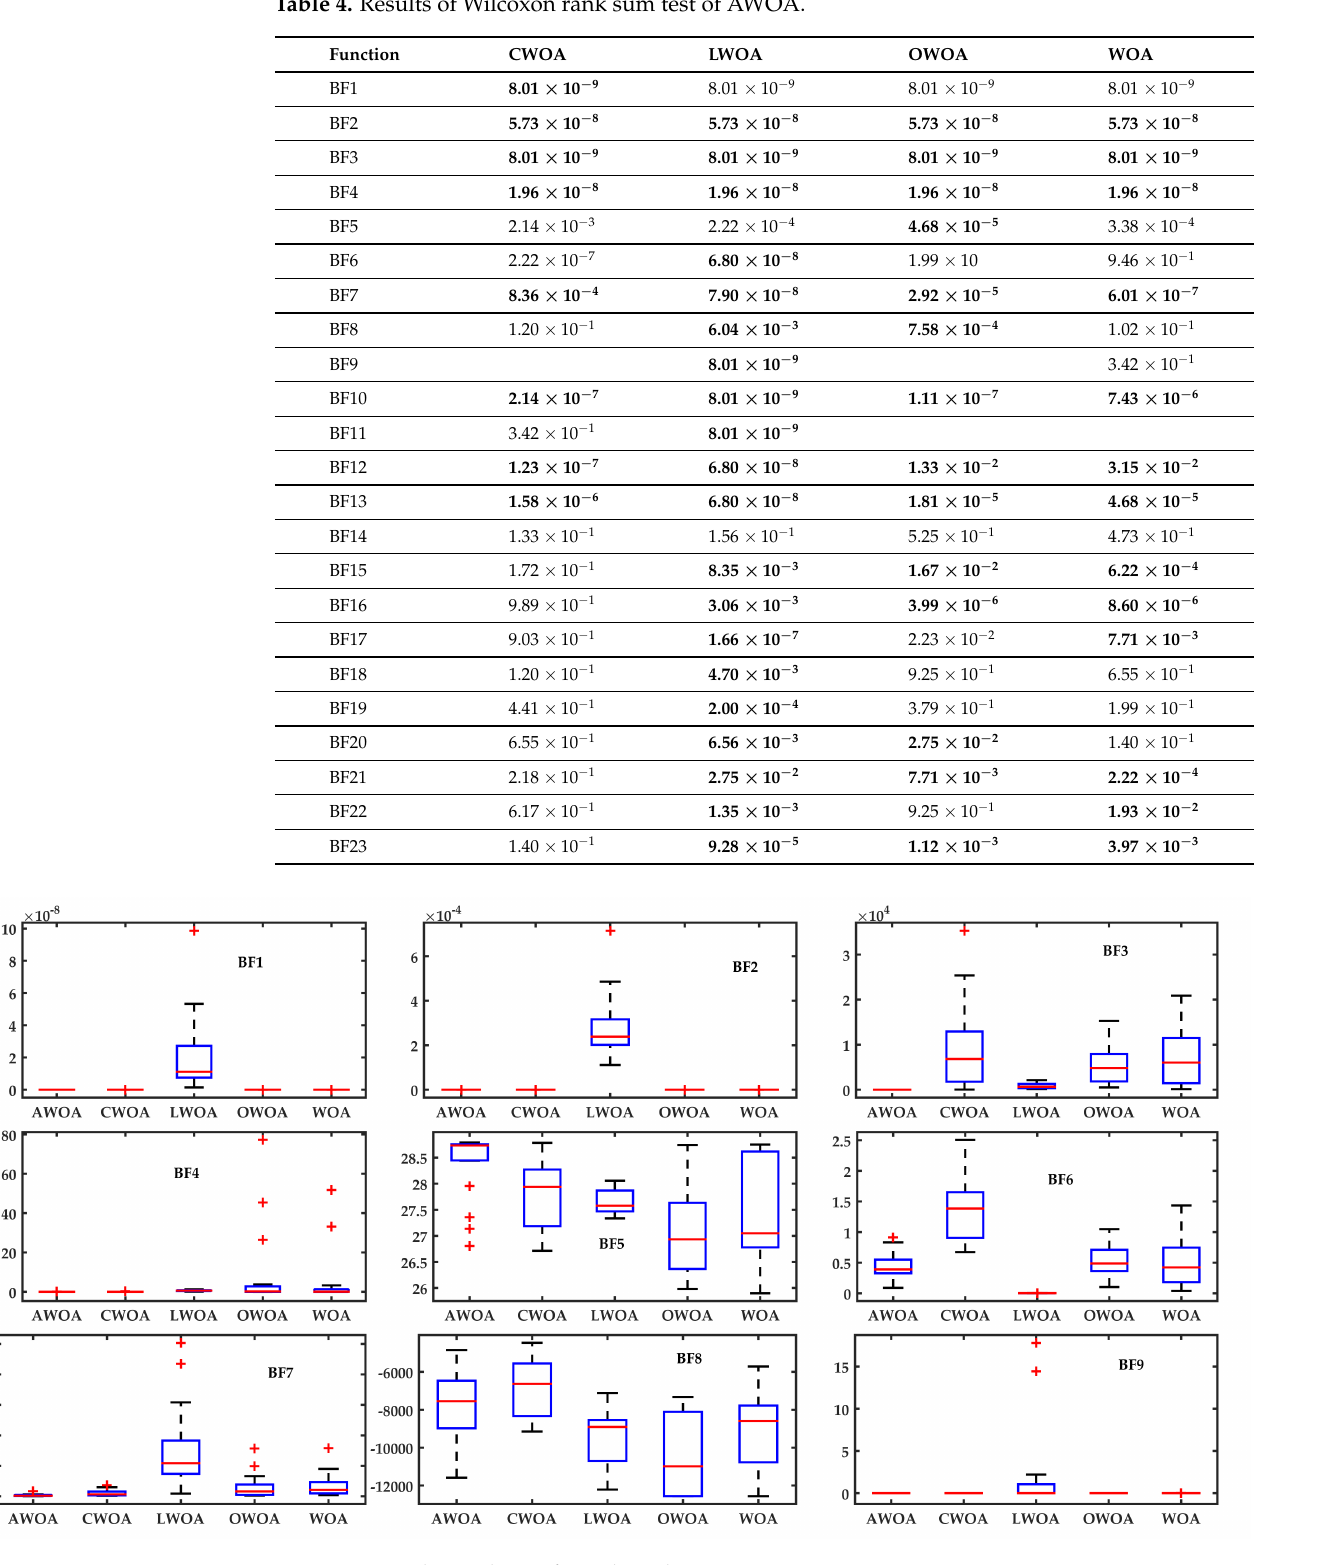
Figure 7. Boxplot analysis of Benchmark Suite